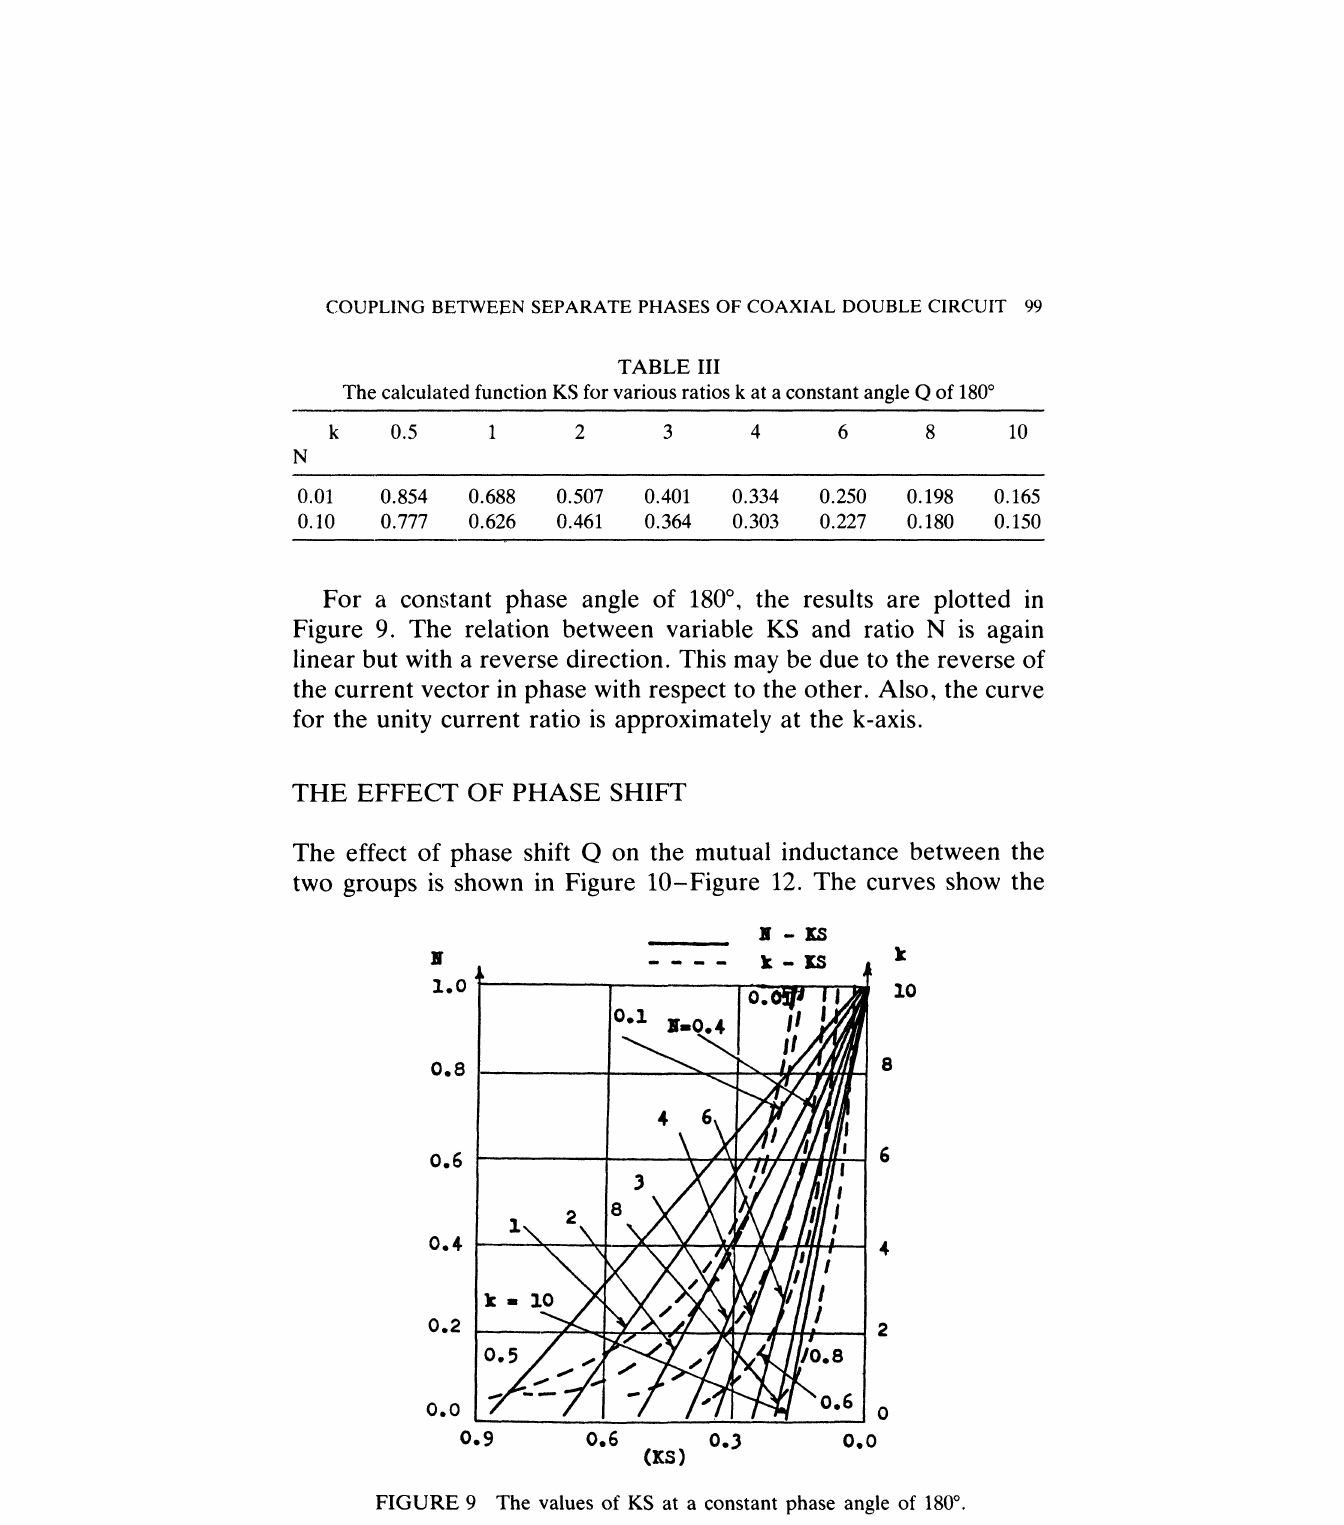
FIGURE 9 The values of KS at a constant phase angle of 180